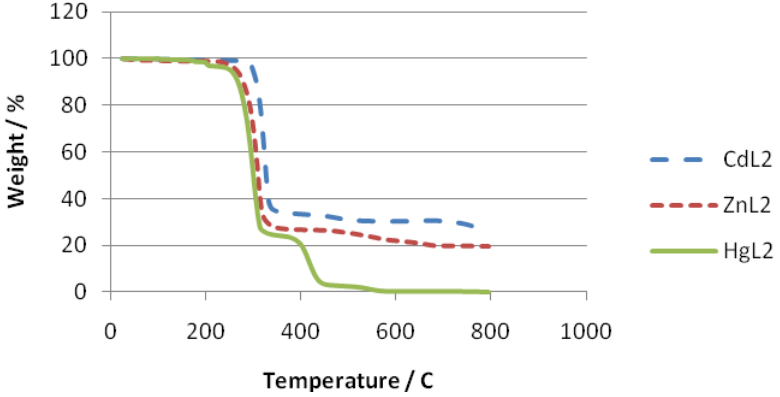
Figure 1. TGA curves showing the degradation of complexes.